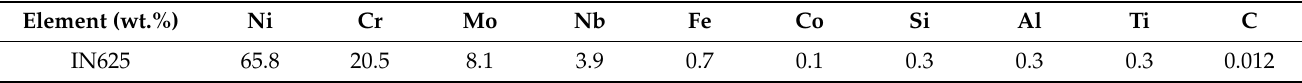
Table 1. IN625 chemical composition.